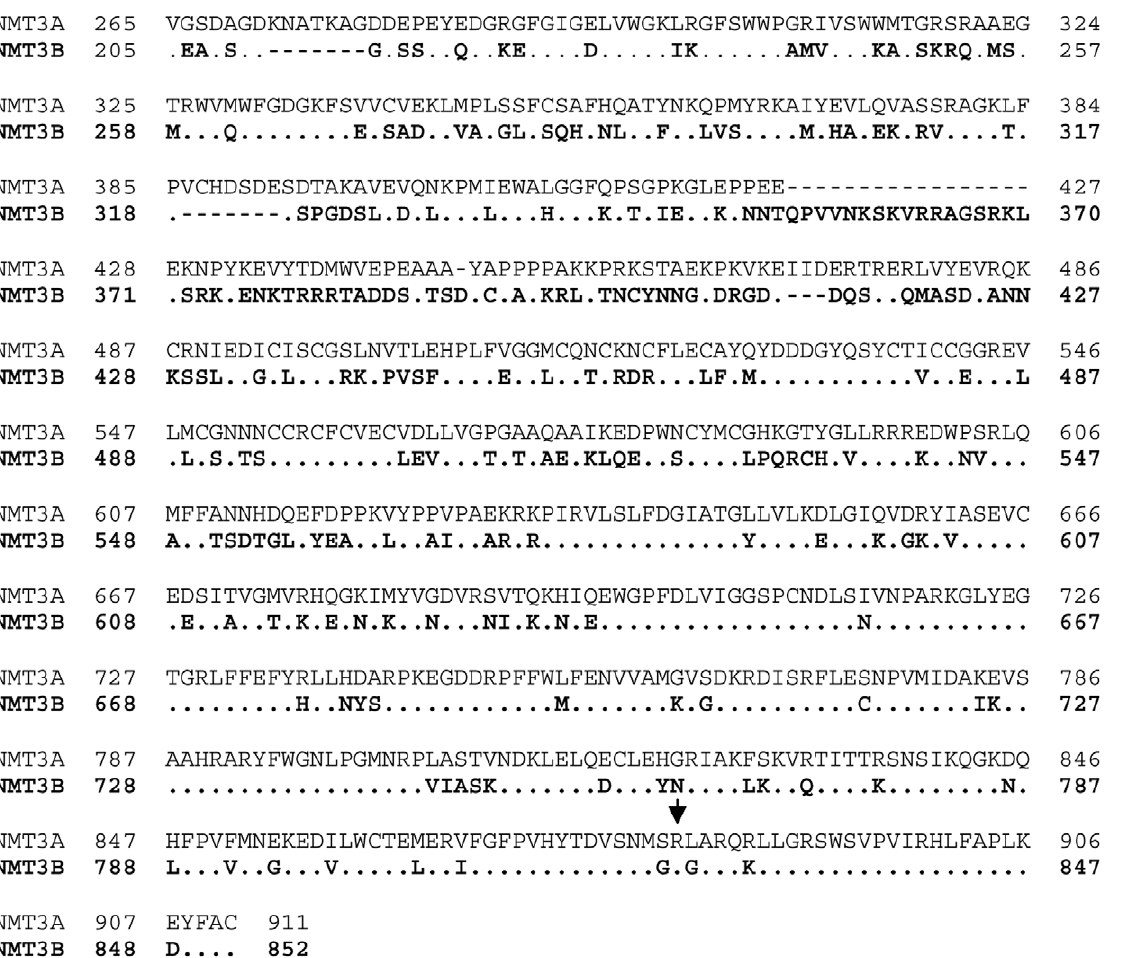
Figure 2. Alignment of DNMT3A with DNMT3B (in bold). The mutation site R882 of DNMT3A (corresponds to R823 in DNMT3B, which has been found mutated in ICF syndrome) is indicated by an arrow. Pairwise with dots stands for amino acid identities and dashes for gaps. Identities=399/665 (60%), Positives=489/665 (74%), Gaps=35/665 (5%).